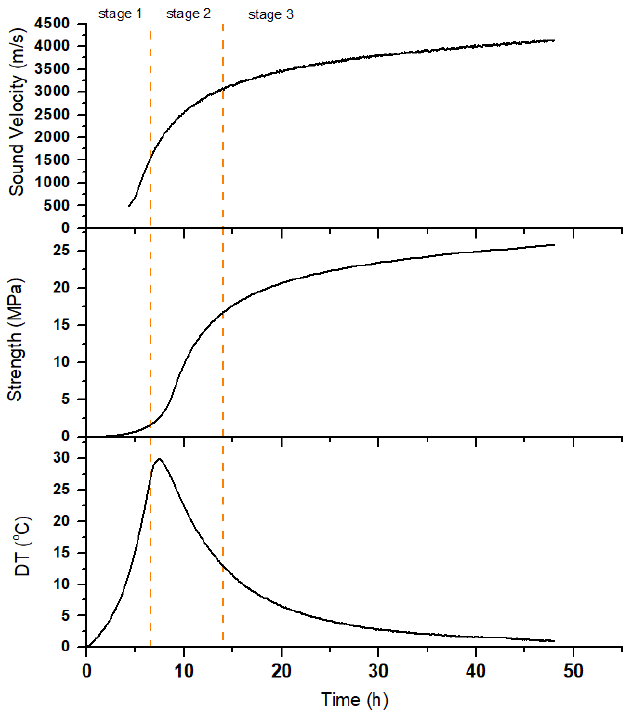
Figure 2. Typical results of cement paste with w/c ratio equal to 0.4. Acoustics 2020 , 3 FOR PEER REVIEW